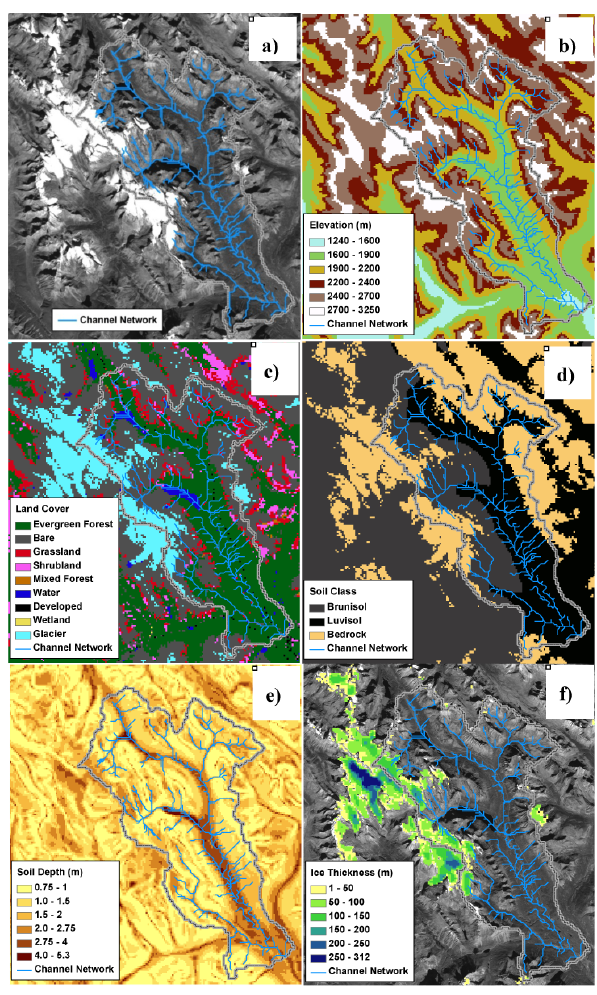
Fig. 3. Input raster data sets used in the study: (a) DEM-derived stream network; (b) 90meter SRTM DEM; (c) Land cover classes; (d) soil classes; (e) Spatial distribution of DEM-derived soil depth; (f) subglacial